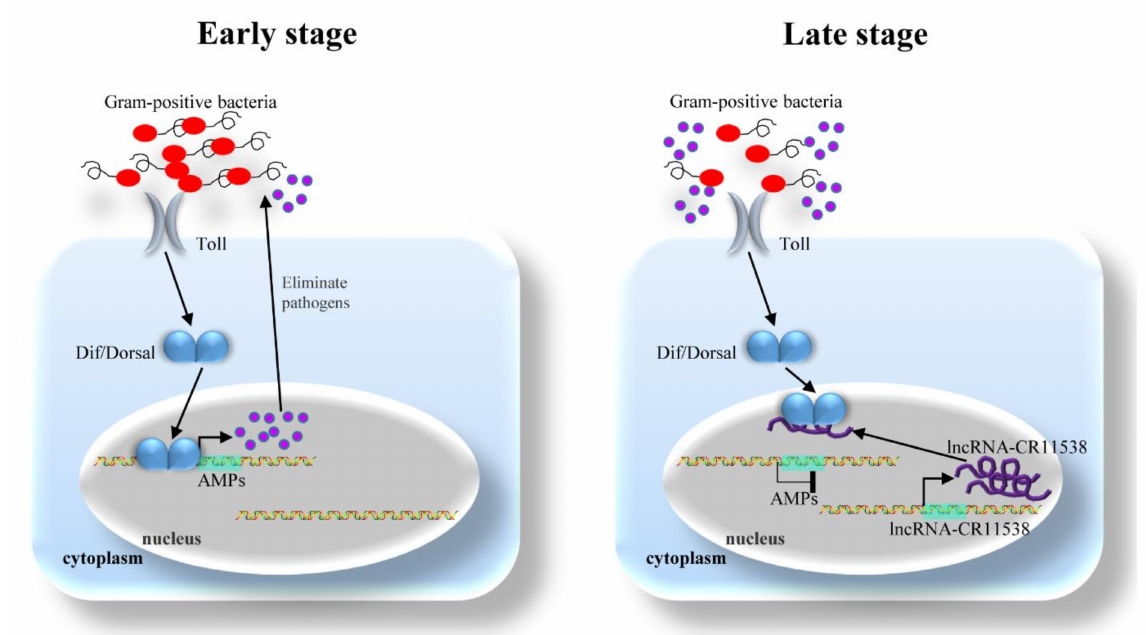
Figure 7. Schematic illustration of the mechanism by which lncRNA-CR11538 facilitates immune homeostasis recovery. Left diagram: In the early stage of immune response, Gram-positive bacteria activate Toll signaling pathway and promote Dif/Dorsal entering the nucleus to enhance AMP transcriptions, thereby eliminating pathogens. Right diagram: In the late stage of immune response, redundant AMPs increase the expression of lncRNA-CR11538 , which acts as a Dif/Dorsal decoy to sequester them away from AMP promoters and inhibits the transcriptions of AMPs to restore immune